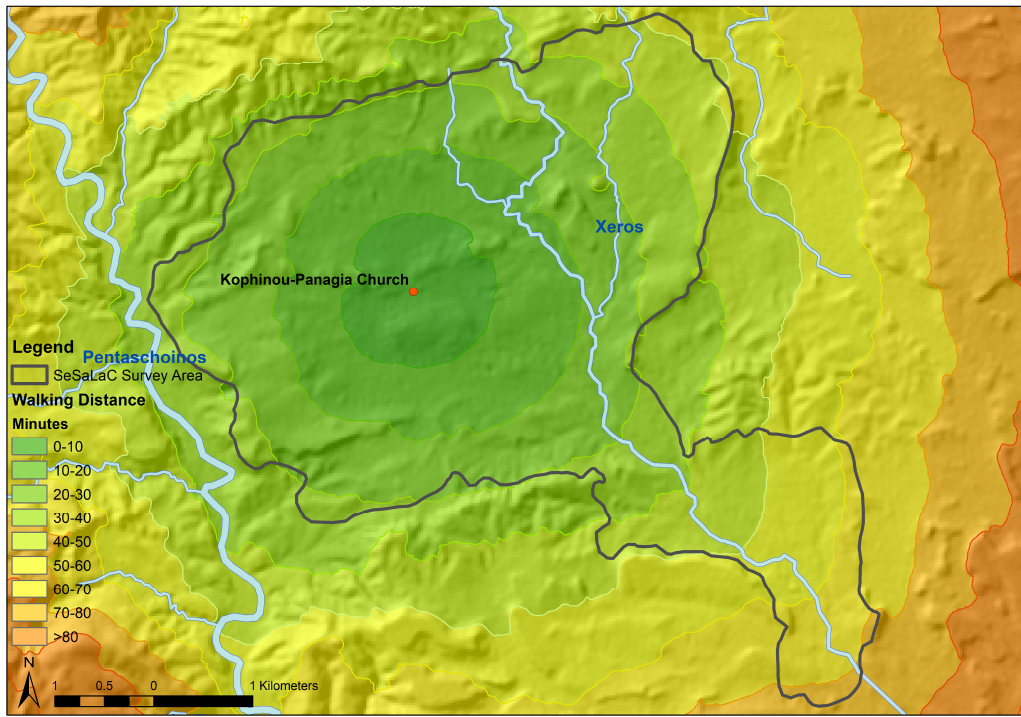
Figure 28. Cost Surface Analysis from the Late Antique site of Kophinou-Panagia at the centre of the Xeros River valley. Digital data courtesy of the Geological Survey Department, Republic of Cyprus (GIS analysis by Charalambos